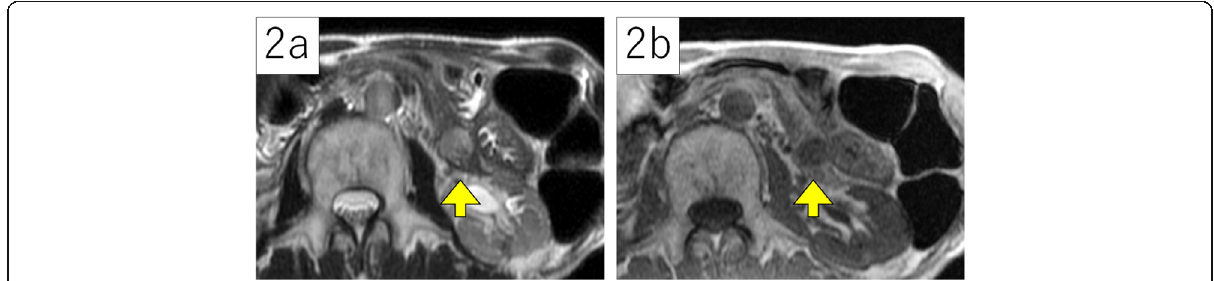
Fig. 2 Magnetic resonance imaging (MRI) showed high signal intensity in T2WI ( 2a ) and low intensity in T1WI ( 2b ), each indicated with